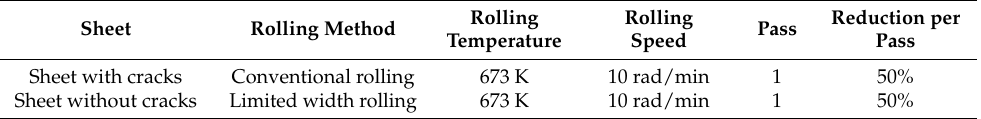
Table 2. Rolling parameters for hot rolling of the magnesium